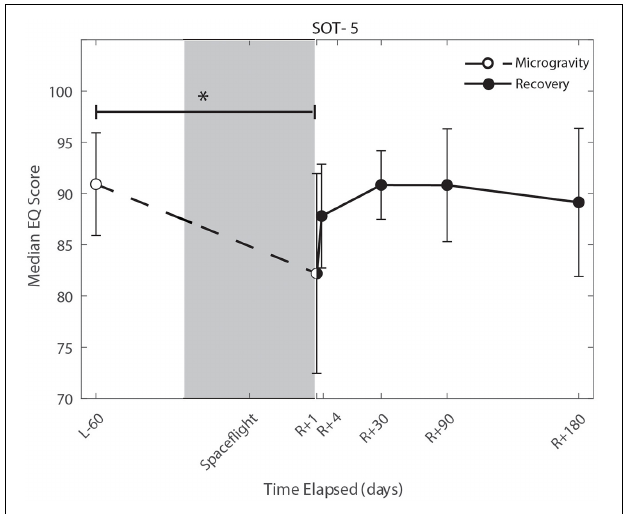
FIGURE 5 | Bimanual purdue pegboard completion time changes from pre- to post-flight and post-flight recovery. There was a significant increase in completion time ( p = 0.008) pre- to post-flight. There was a significant change in recovery ( p = 0.016). *Indicates statistical results that are p < 0.05.